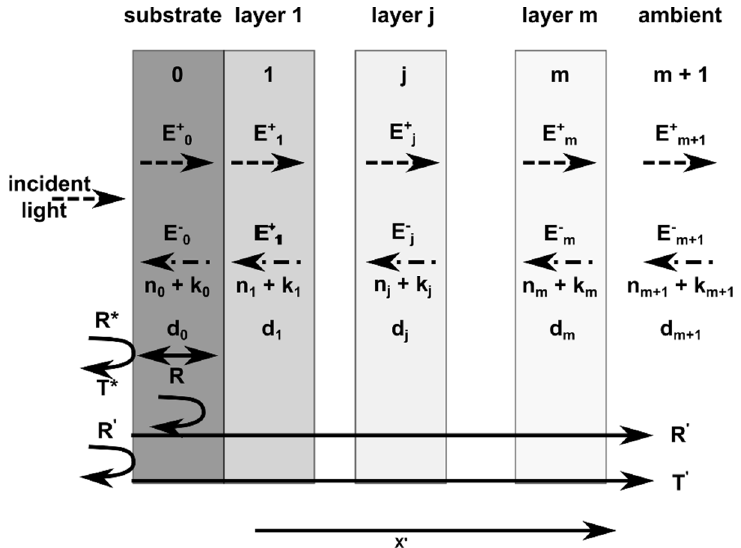
Figure 2. Schematic diagram of an organic solar cell stack, indicating light incident from the left side of the device. Starting from the left, the layers are indexed as j = 0 starting with the glass substrate to j = m + 1 for the air medium (far right beyond the OSC). E is the electric field of the electromagnetic radiation propagating through the device. E + and E − are the forward and reflected components of E at each interface, respectively; d j represents the thickness of the jth layer’ and R and T represent, respectively, reflection and transmission of E through the whole device.